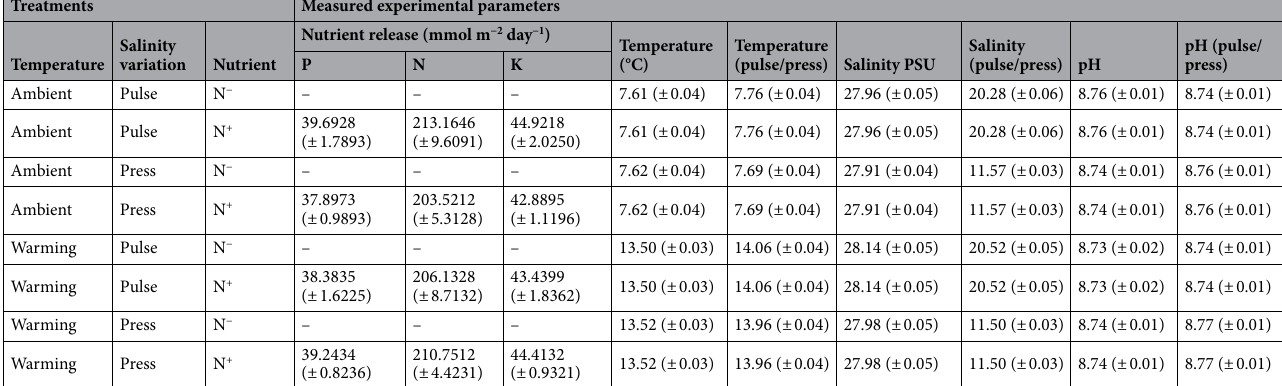
St. Lawrence (Table 1) 54 . For stress induced by salinity variations, we generated pulses and presses of freshwater instead of using stable salinities as being intertidal, the organisms are used to being exposed to freshwater during low tide and salt-water during high tide. The pulse treatment corresponded to periodic drops of salinity, passing